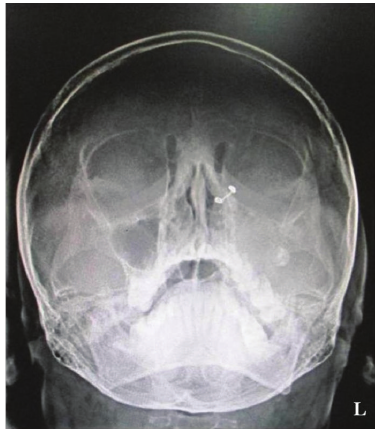
Figure 4: PNS view showing destruction of floor of maxillary antrum on left